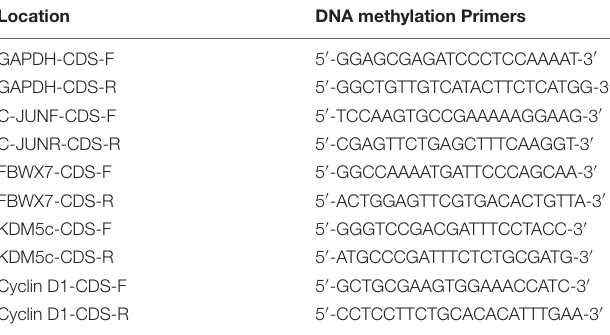
TABLE 2 | The primers used in the 3C-ChIP-PCR assays. Location Primers